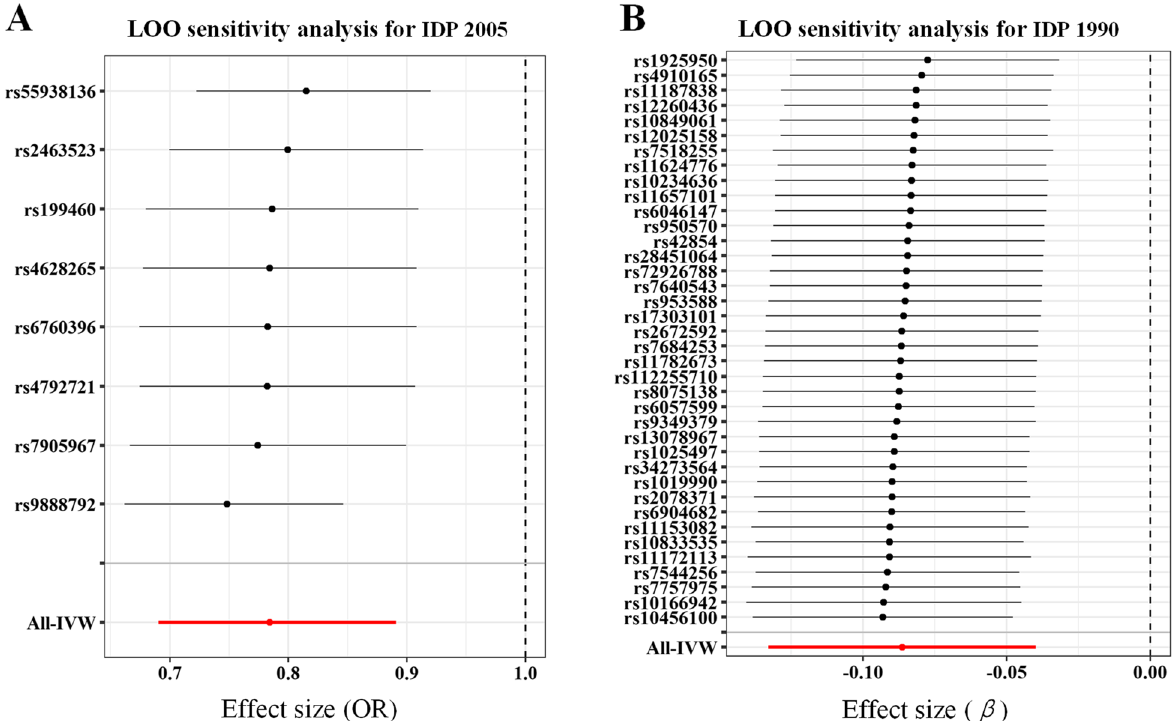
Fig. 4 LOO sensitivity analysis. A Forward LOO sensitivity analysis for the OD in right posterior thalamic radiation (IDP 2005). B Reverse LOO sensitivity analysis for the OD in left superior cerebellar peduncle (IDP 1990). Each black point represents the IVW causal estimates after excluding the respective SNP from the analysis, and the error bars represent 95% CI. The red point represents the IVW causal estimates using all SNPs, and the error bars represent 95% CI. There is no dramatic change in causal estimates after excluding one particular SNP. Abbreviations: IDP, imaging-derived phenotypes; IVW, inverse variance-weighted; LOO, leave-one-out; OR, odds